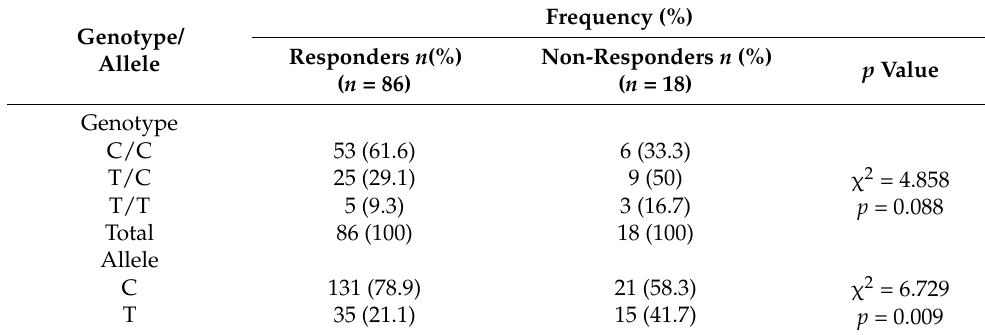
Table 4. Frequency of the ABCA1 rs1883025 genotypes in the responder and non-responder groups.